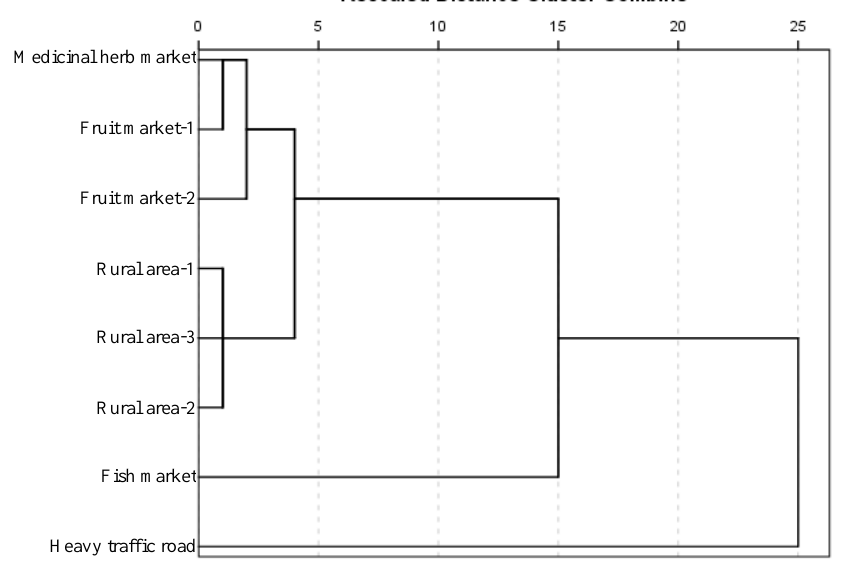
Figure 5. Dendrogram showing the clustering of the street dust samples. Similarities have been calculated from Euclidean distance.